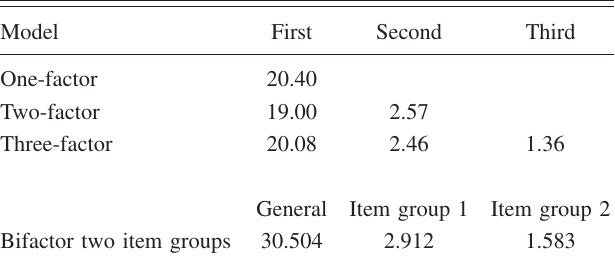
TABLE VI. Variance explained by each factor in one-, two-, and three-factor models and a bifactor model with guess estimates, respectively.